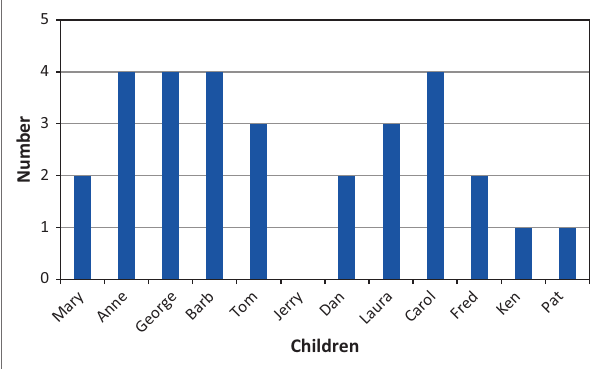
FIGURE 2: Number of books read by each of the 12 children.